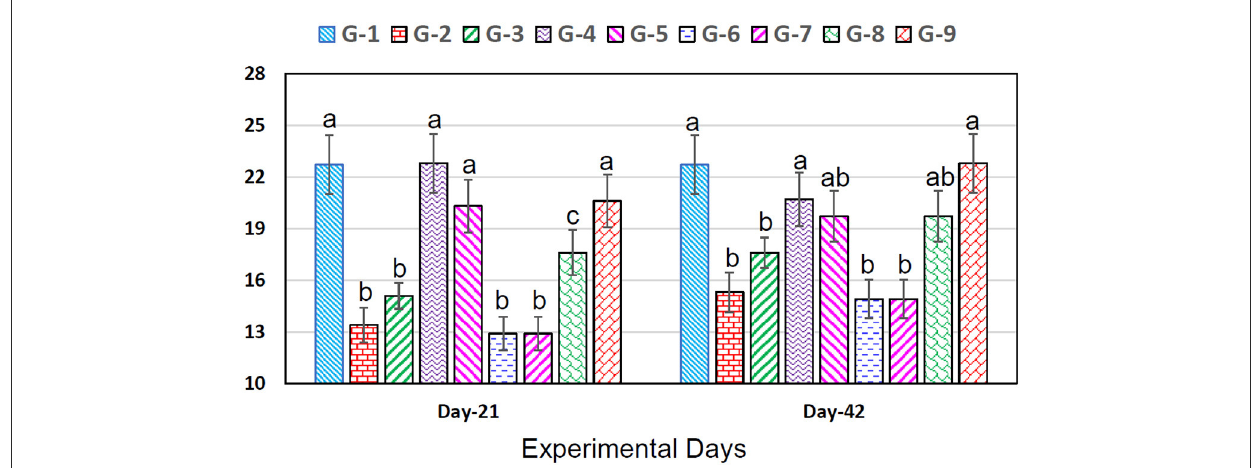
FIGURE1 Leukocyte counts ( × 10 3 / µ L) in broiler chicks on 21 and 42 experiment days administered arsenic, chromium, vitamin E, and bentonite alone or in combinations. Bars (mean ± SE) having dissimilar letters under a specific experimental day vary significantly ( p < 0.05). Chromium, arsenic, and vitamin E were given @ 270, 50, and 150mg.kg − 1 , respectively, while bentonite was administered @ 5%. G1 = Group 1: Control (negative); G2 = Group 2: Chromium; G3 = Group 3: Arsenic; G4 = Group 4: Vitamin E; G5 = Group 5: Bentonite; G6 = Group 6: Chromium + Arsenic; G7 = Group 7: Chromium + Arsenic + Vitamin E; G8 = Group 8: Chromium + Arsenic + Bentonite; and G9 = Group 9: Chromium + Arsenic + Vitamin E + Bentonite.